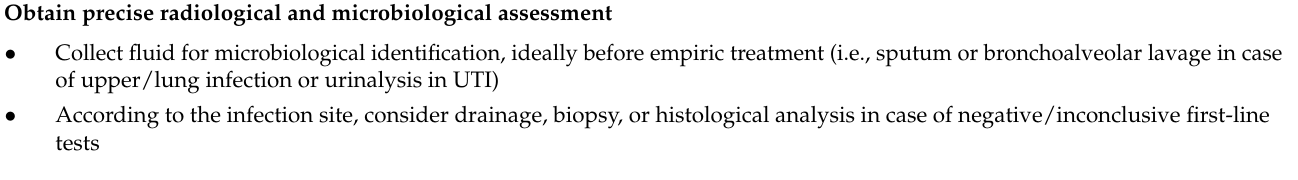
Table 1. The black box of consideration for kidney transplant bacterial and viral infectious